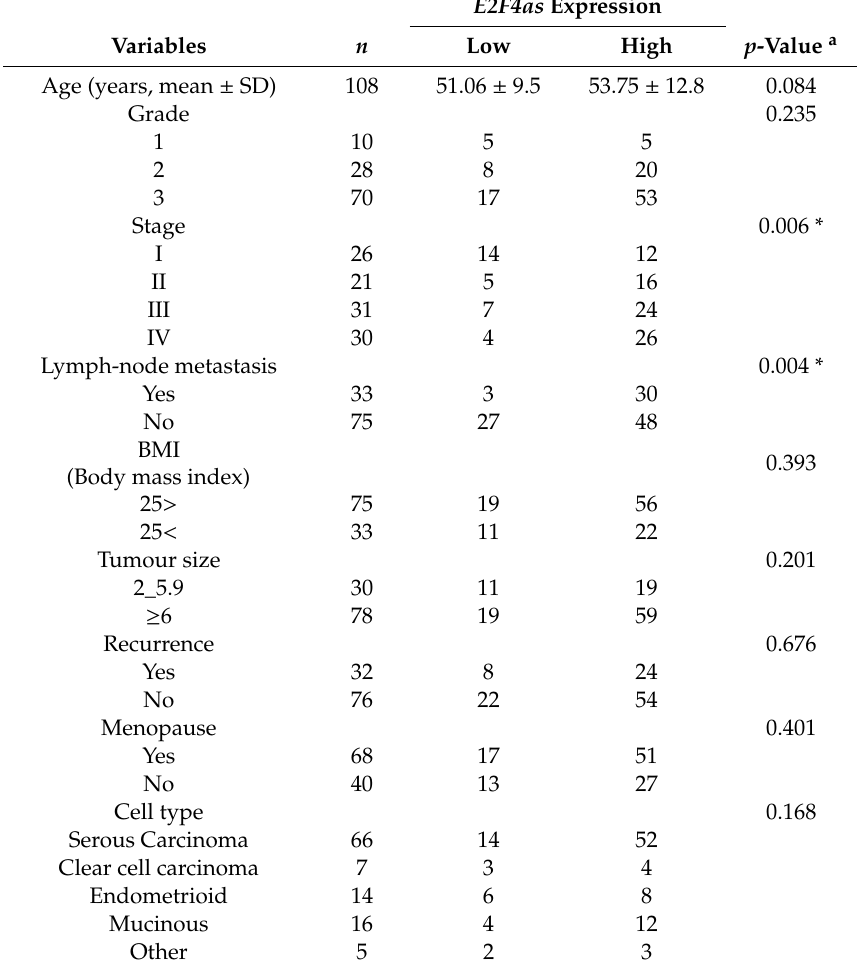
Table 1. Clinicopathologic factors in benign ovary serum and ovarian cancer serum samples. E2F4as Expression Variables